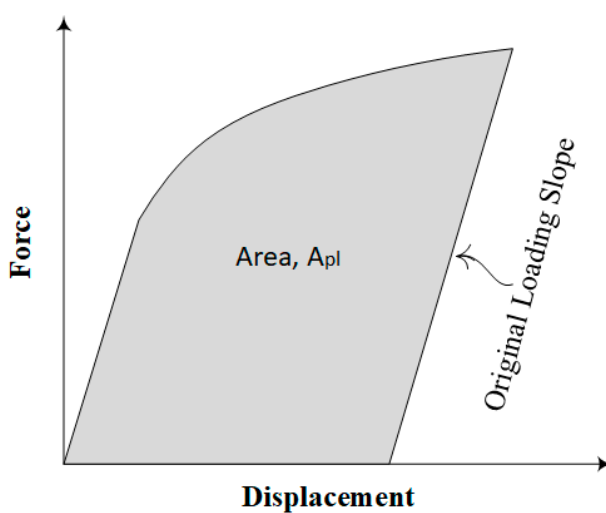
Figure 7. A pl area definition from load-displacement curve. Figure 7. 𝐴 (cid:3043)(cid:3039) area definition from load-displacement curve. Figure 7. 𝐴 (cid:3043)(cid:3039) area definition from load-displacement curve.